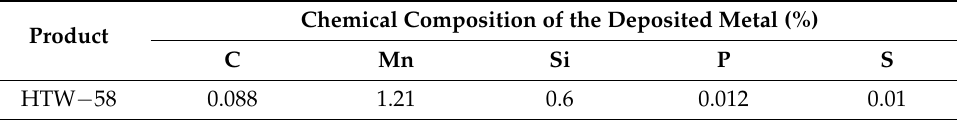
Figure 5. Welding direction. In the welding of thick steel plate, the welding path is divided into bottom welding, filling welding and cover welding. Bottom welding gives priority to heat input control to avoid defects such as breakdown and incomplete welding. Generally, welding current and voltage are slightly smaller. Filler welding can improve production efficiency and melt speed of welding wire as much as possible on the premise of ensuring welding qual ‐ ity. The welding current and voltage are slightly larger than that of bottom welding. The main purpose of cover welding is to cover the groove to ensure the quality. The determi ‐ nation of welding current and voltage is based on experience of the manufacturing fac ‐ tory. In multi ‐ layer and multi ‐ pass welding, increasing welding parameters are helpful to improve the welding rate when the heat input is not exceeded. The specific welding pa ‐ rameters used in this paper are provided by the manufacturer. The welding process pa ‐ rameters are shown in Table 6. Table 6. Welding process parameters. Weld Bead Interpass Tem- perature ( ℃ )